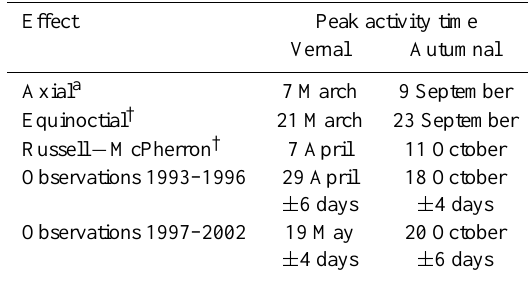
Table 1. Observed times of peak fluxes for the 2- to 6-MeV electrons together with the expected times for the axial, Russell- Mcpherron and the equinoctial effects. Correcting for finite solar wind speed adds ≈ 4 days to the nominal times for the equinoctial